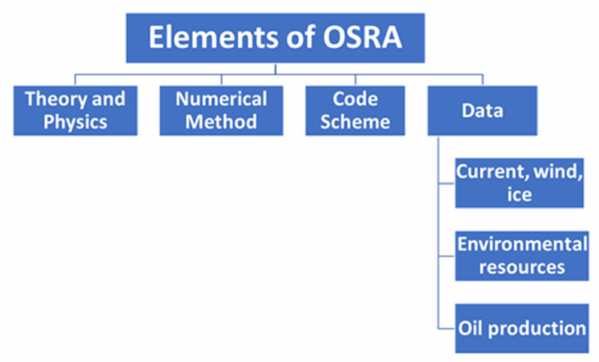
Figure 1. Key elements of the oil spill risk analysis (OSRA)